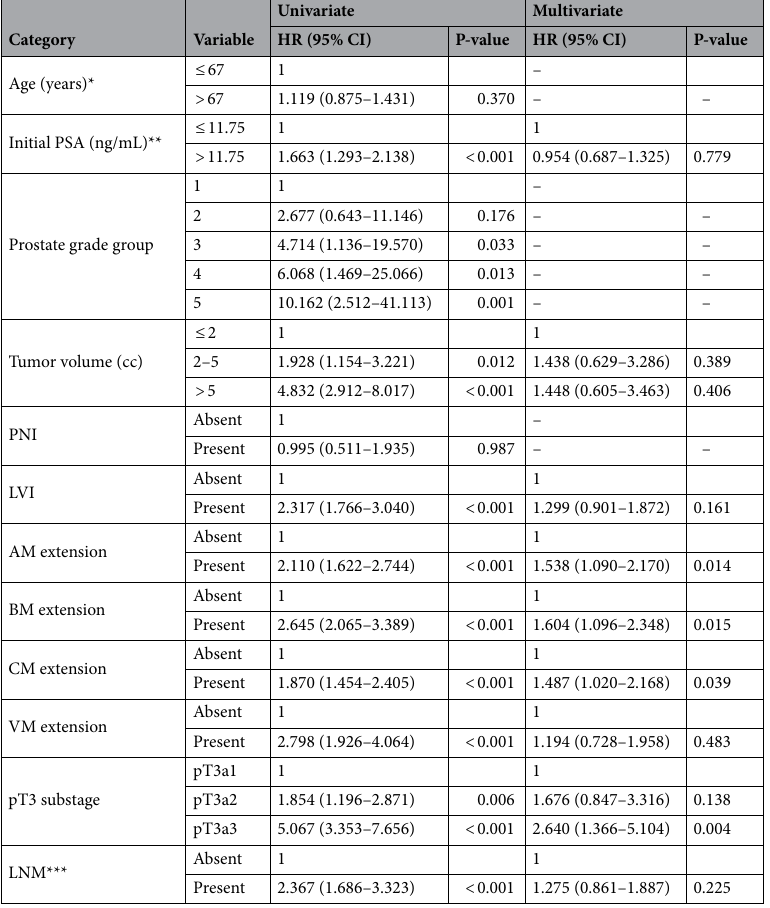
Table 4. Univariate and multivariate analysis of 465 prostate cancer cases on BCR-free survival. BCR, biochemical recurrence; PSA, prostate specific antigen; PGG, prostate grade group; PNI, perineural invasion; LVI, lymphovascular invasion; AM, apex margin; BM, basal margin; CM, circumferential margin; VM, vas deferens margin; LNM, lymph node metastasis. *Median age of 465 patients was 67.0 years. **Median level of initial PSA was 11.75 ng/mL. ***Evaluated in 236 cases.